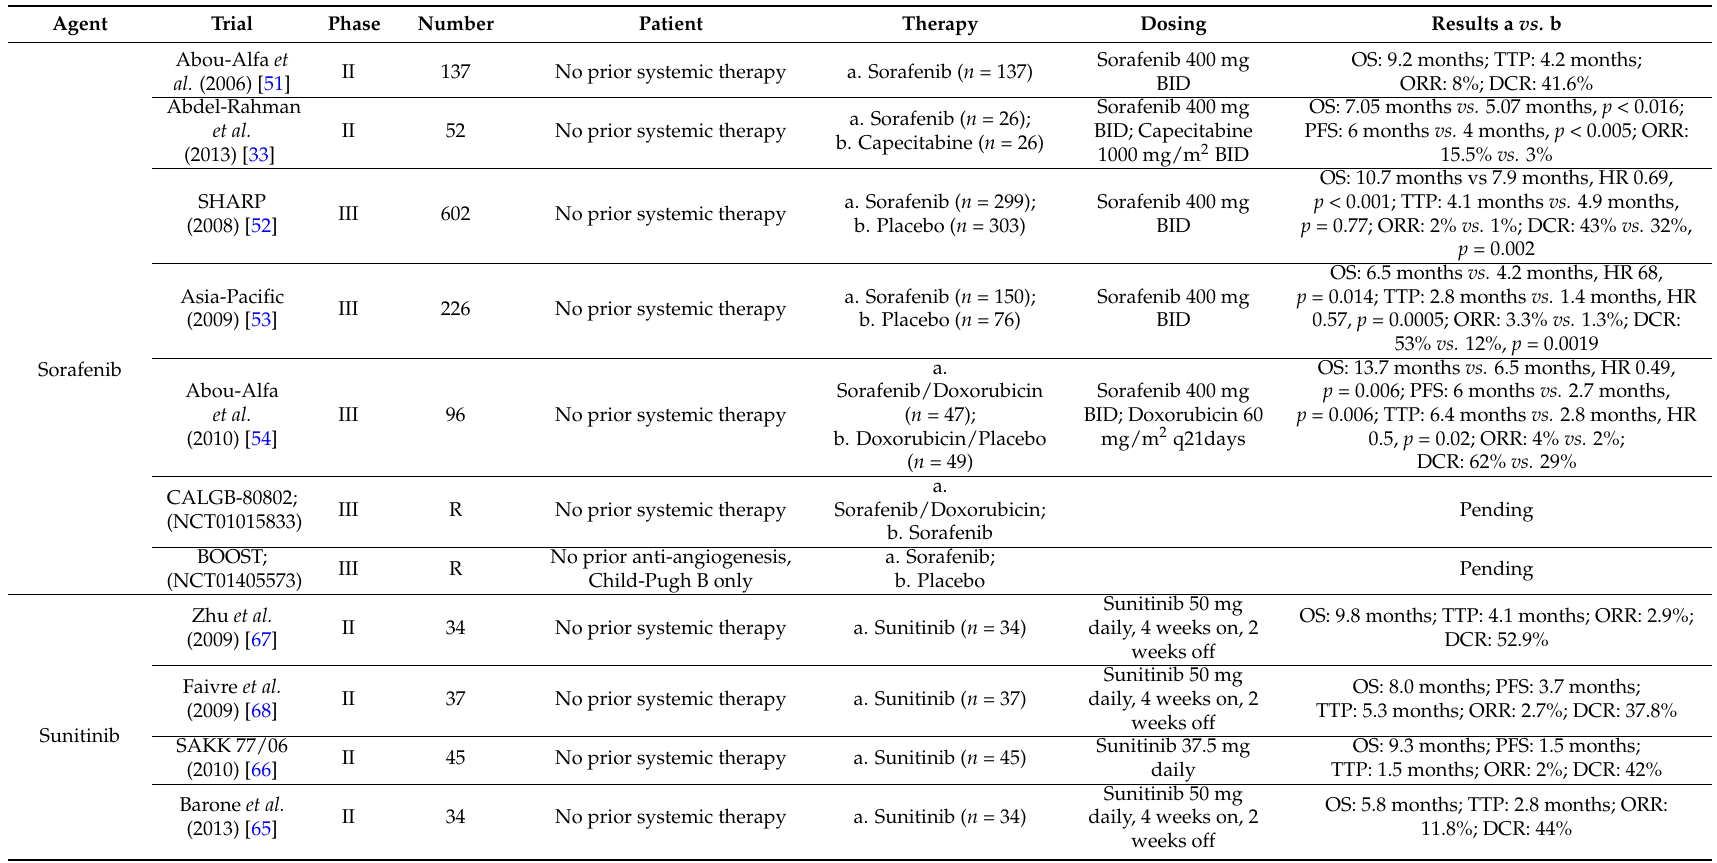
Table 1. Anti-VEGF